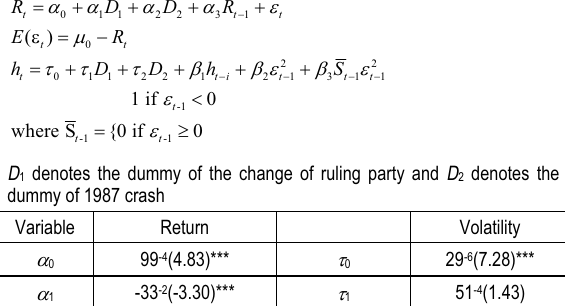
1987 stock market crash and the previous day’s returns of stock,